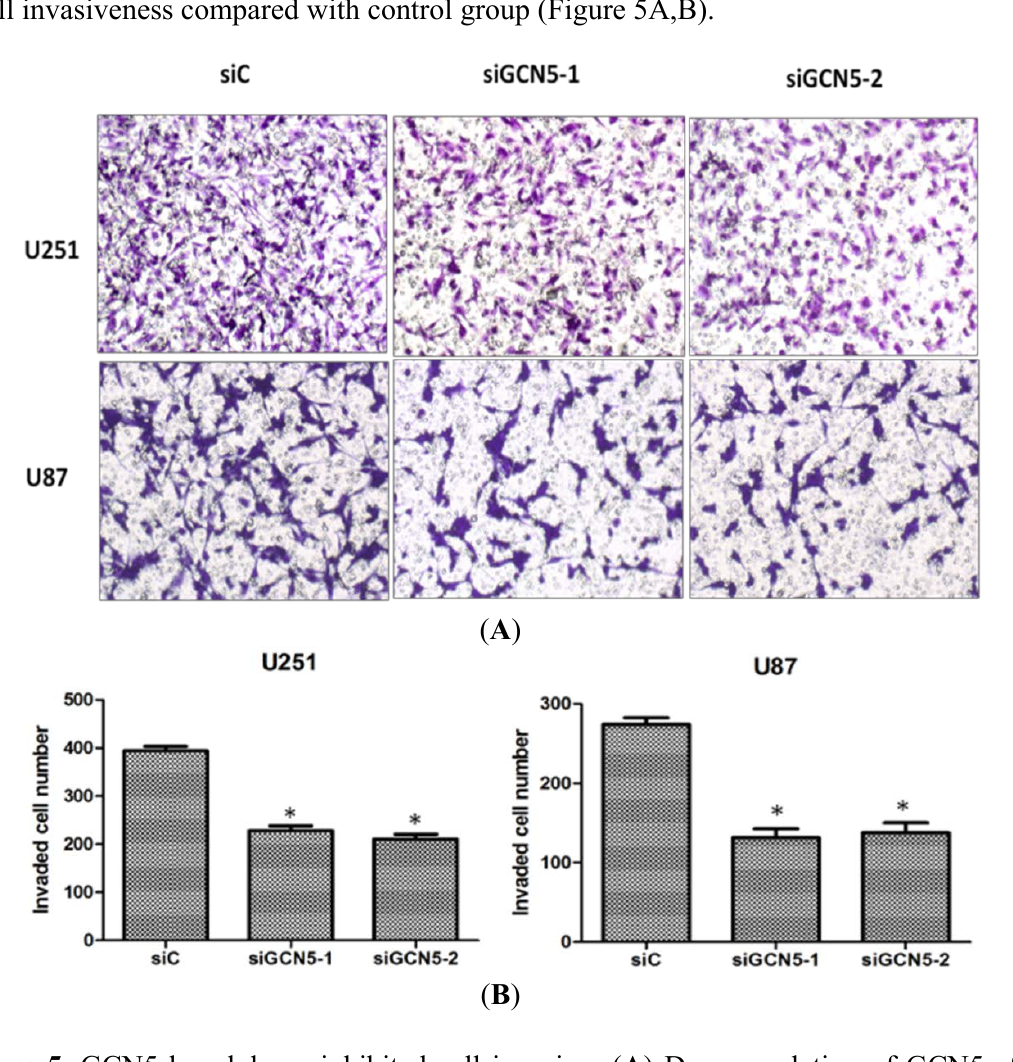
Figure 5. GCN5 knockdown inhibited cell invasion. ( A ) Downregulation of GCN5 after siRNA treatment inhibited cell invasion in U251 and U87 cell lines (Magnification× 100); and ( B ) Quantification analysis showed that GCN5 knockdown could suppress cell invasion in U251 and U87 cell lines (* p <